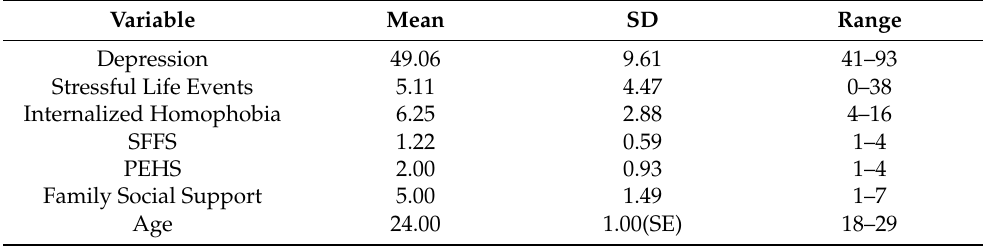
Table 1. Demographics ( N =